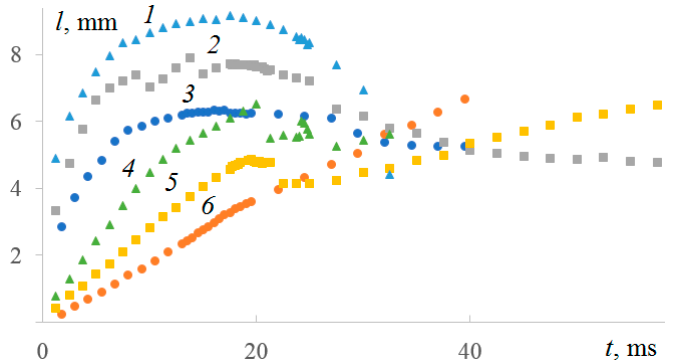
Figure 9. Evolution of intrusion dimensions at different values of drop contact velocity: curves 1, 2, 3—diameter, 4, 5, 6—intrusion height at U = 1.0, 0.6 and 0.34 m/s, respectively.